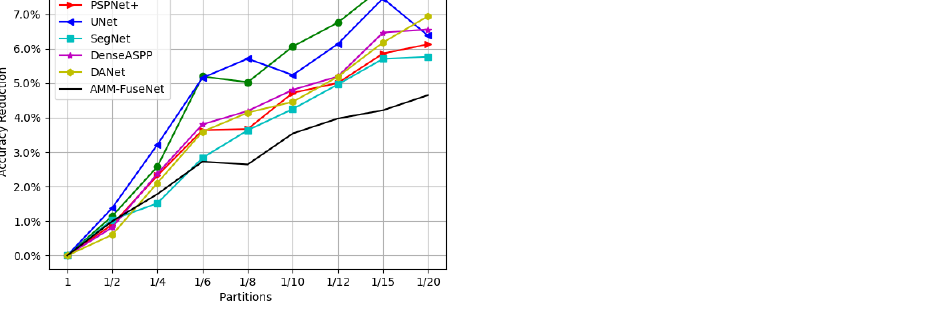
Figure 12. Percentage decrease on accuracy for different partitions of the Potsdam dataset for each